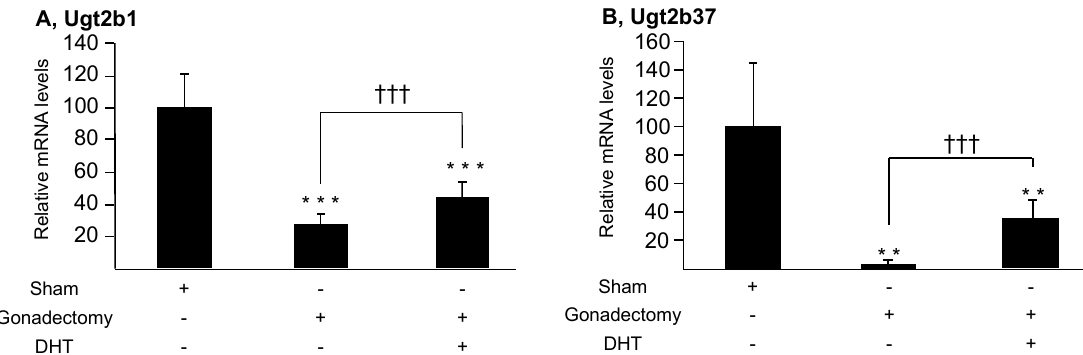
Figure 4. Gonadectomy and/or DHT differentially affect mRNA expression of the androgen- conjugating Ugt2b1 and Ugt2b37 enzymes in male liver and kidney, respectively. Male mice (90 days old, n = 6/group) were either sham-operated (Sham), gonadectomized, and/or treated with 0.1 mg DHT/day for 14 days, before euthanasia. Livers and kidneys were collected and subsequently investigated for Ugt2b1 ( A ) or Ugt2b37 ( B ) mRNA levels through qRT-PCR analyses. Ugt2b transcript copy numbers were obtained using linear regression with a standard curve that included five log concentrations of the corresponding Ugt2b plasmid and expressed as a percentage of copy numbers of control (sham) animals. Statistical analyses: Student’s T test. **: p < 0.005, ***: p < 0.001: versus sham; and ††† : p < 0.001 gonadectomized versus DHT-treated gonadectomized animals.